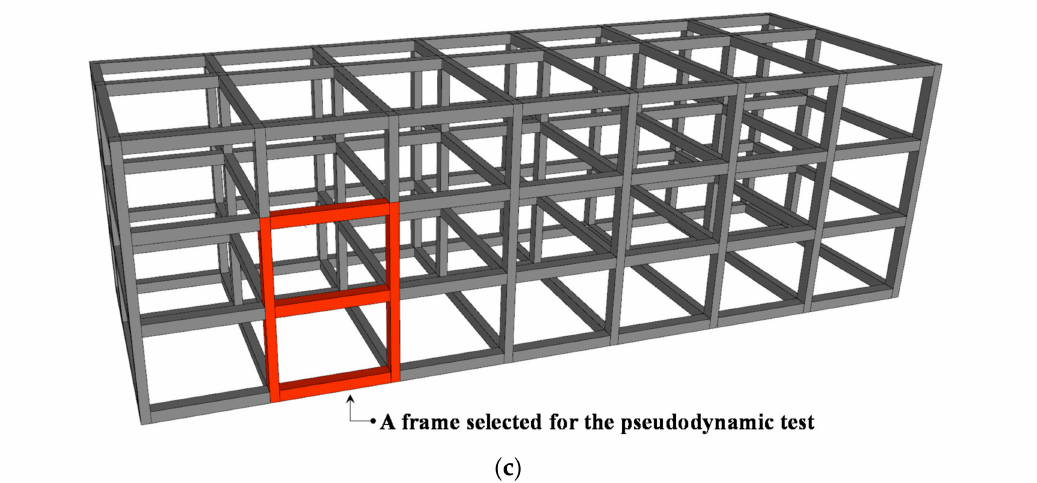
Figure 10. Images of target building and frames selected for pseudo-dynamic testing: ( a ) front view, ( b ) top view, and ( c ) 3D view.